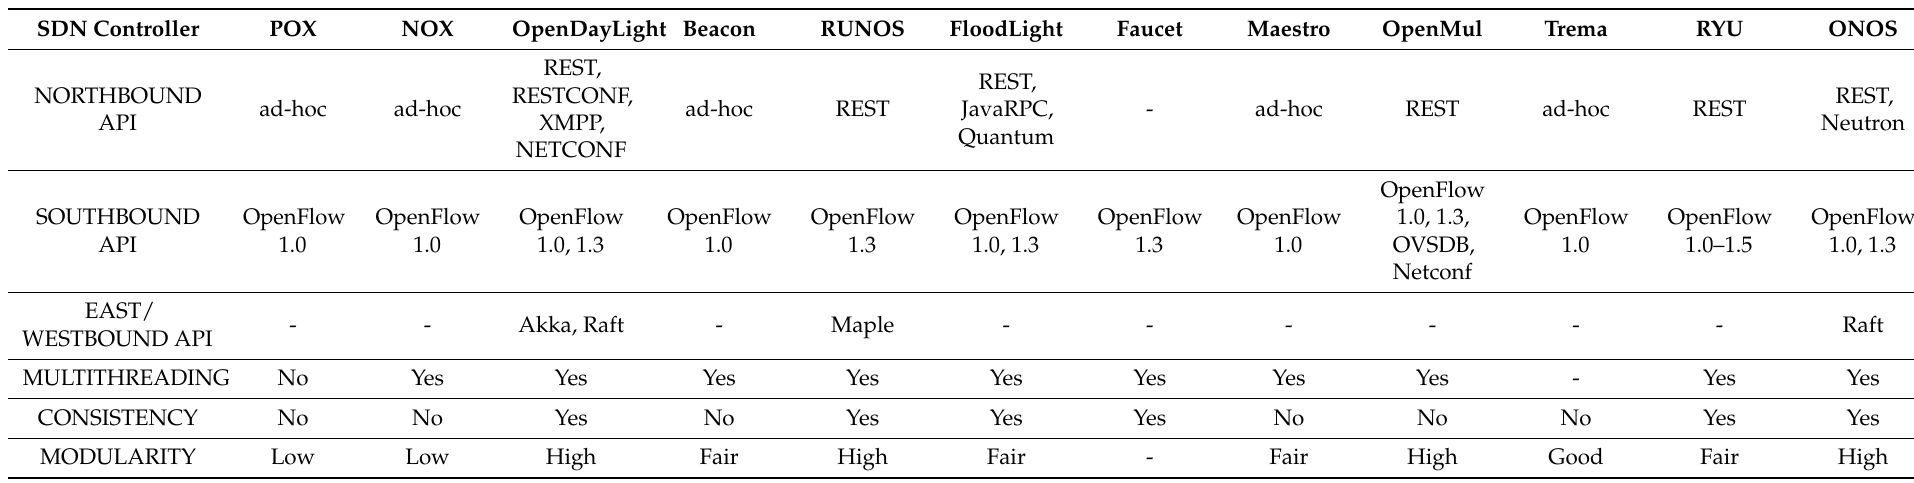
Table 3. Controller’s